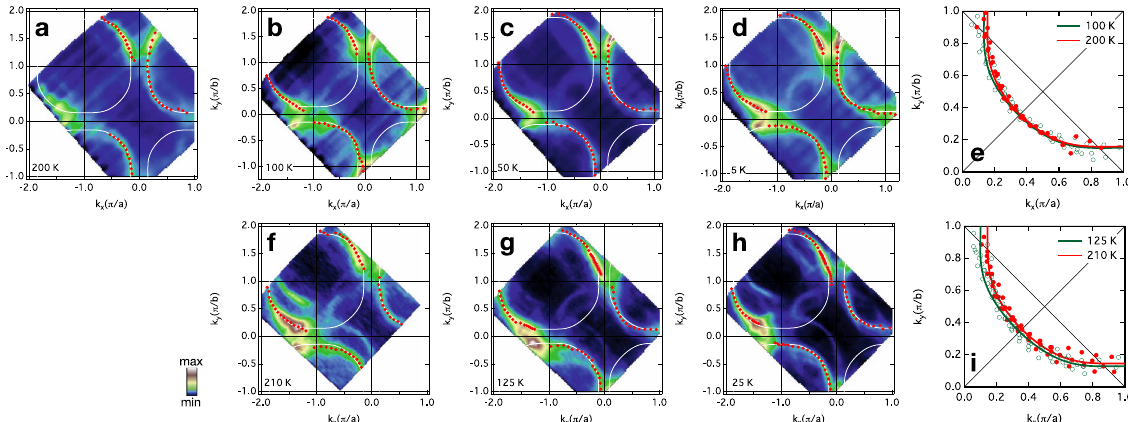
Fig. 2 Constant-energy-surface mapping of the ARPES spectra of Pb-Bi2212 taken at various temperatures. The measurements were performed with decreasing temperature ( a – d ) and increasing temperature ( f – h ). The constant energy is E − E F = − 25 meV ( a – d ) and − 20 meV ( f – h ) and the intensity is integrated within ±10 meV of the constant energy. Red circles show the constant-energy surface determined from the peaks of the momentum distribution curves (MDCs). White curves are the fi tted curves using the tight-binding model of Eq. (2). e Constant-energy surface at 100 and 200 K folded in the fi rst quadrant of the fi rst Brillouin zone and fi tted curves in a range allowed by the symmetry. i Same as e but the data at 125 and 210 K.